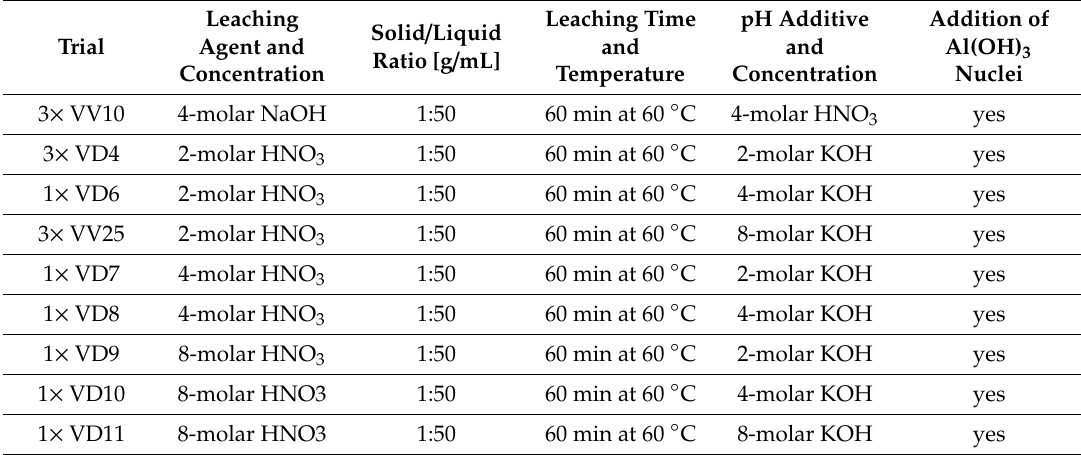
Table 12. Parameter set-ups to be investigated for extracting the best-case scenario for treating Li–S black mass by the hydrometallurgical process suggested in this